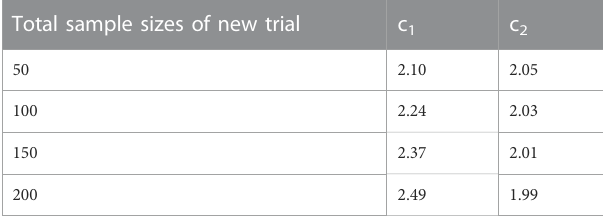
TABLE 1 Sequential boundary for different total sample sizes of new trial in Simulation Study 1. Total sample sizes of new